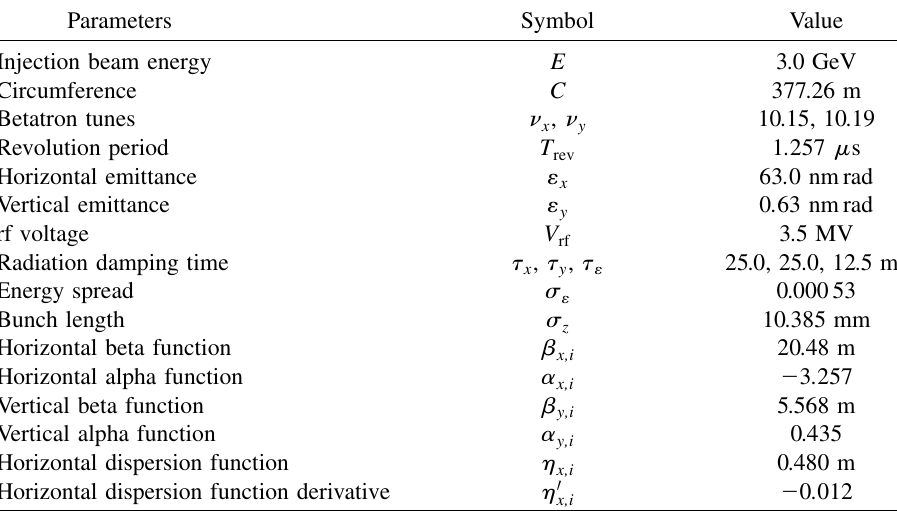
TABLE I. Main parameters of the PF-AR at an injection energy of 3.0 GeV. The Twiss parameters at the injection point are included.